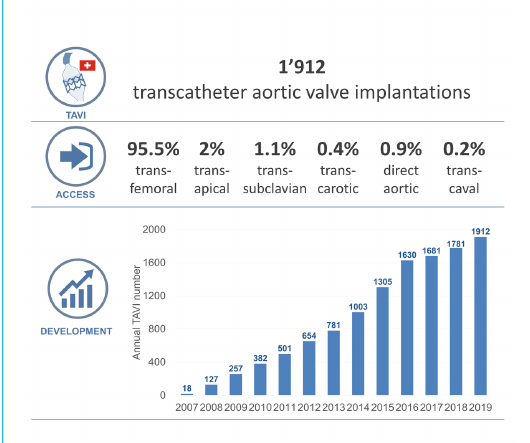
Figure 3: Summary of transcatheter aortic valve implantations in Switzerland